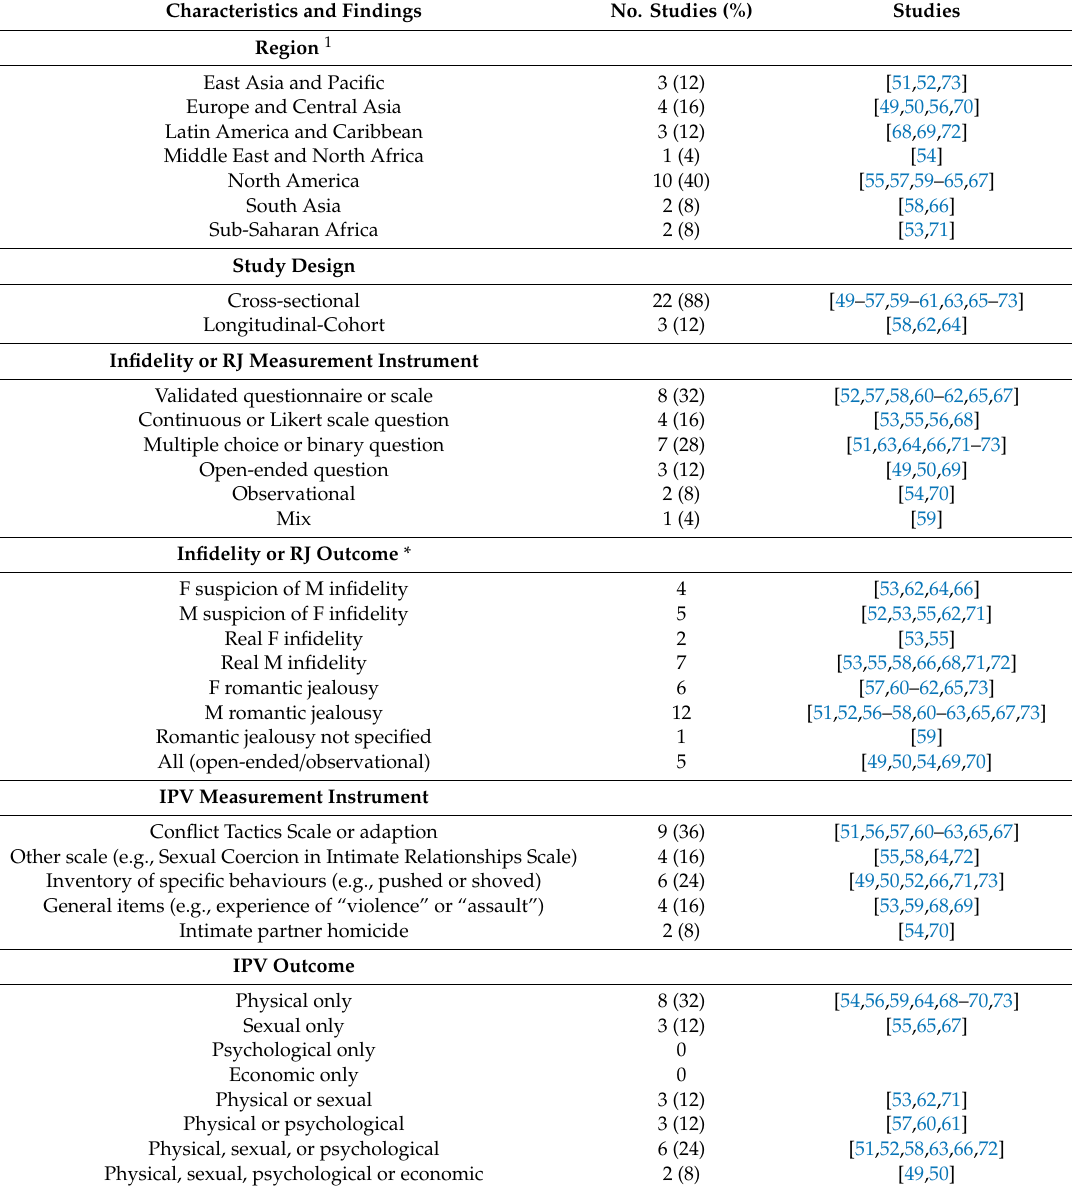
Table 3. Characteristics and findings of included quantitative studies ( n =